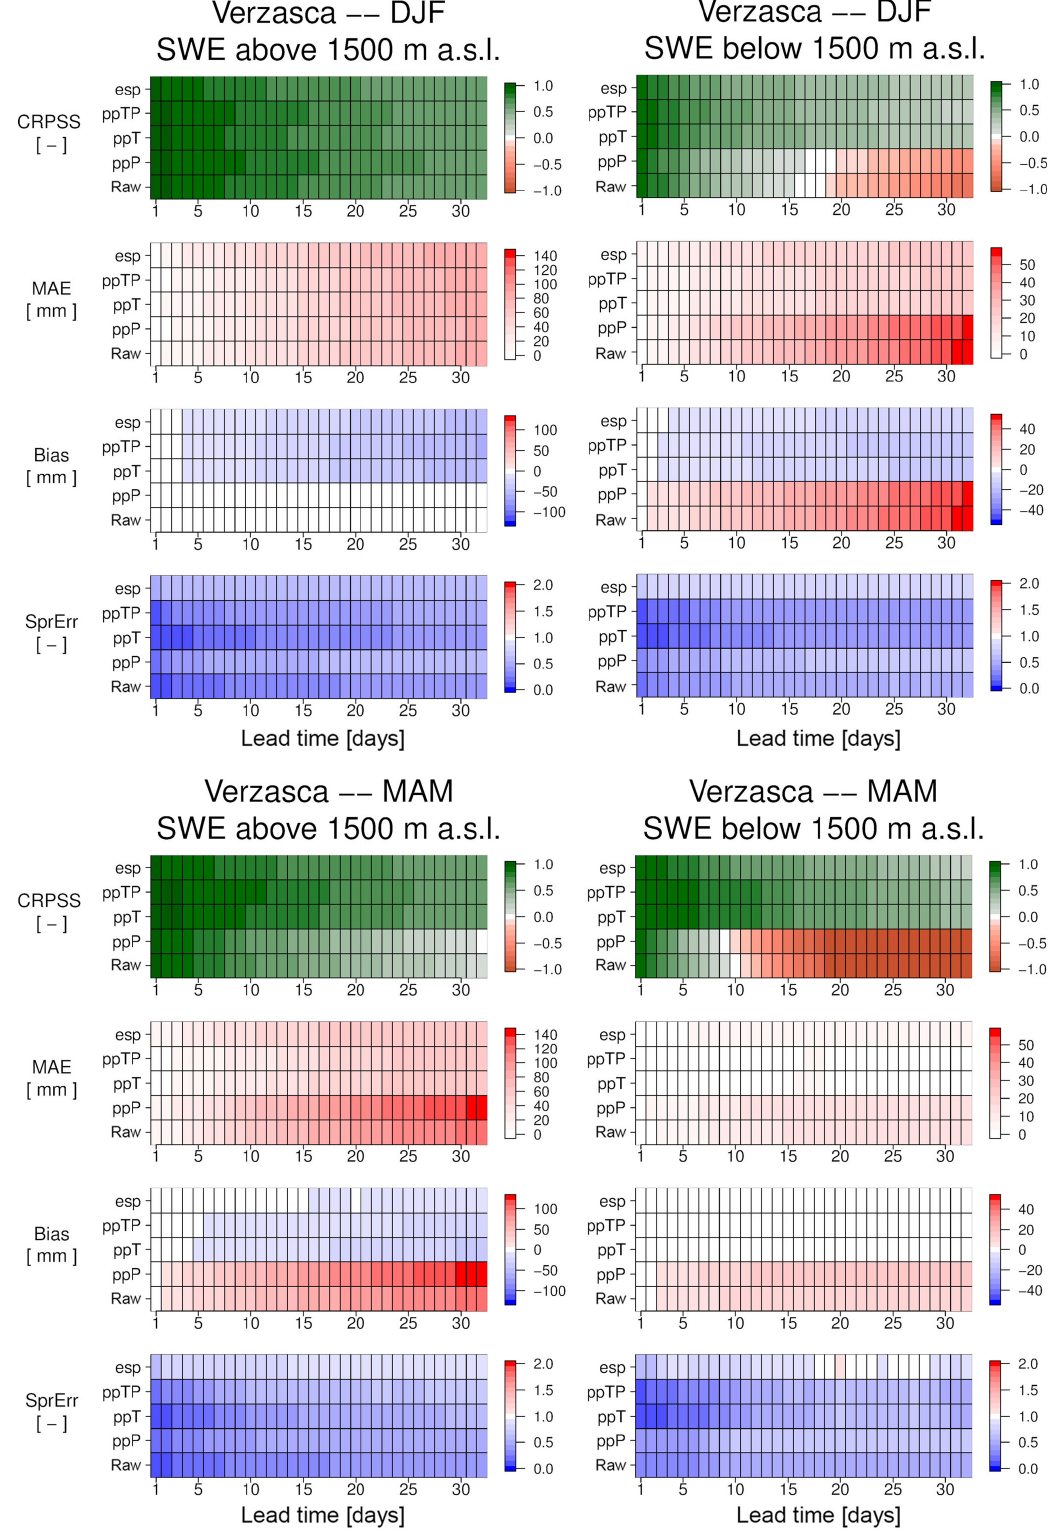
Figure 8. Same as in Fig. 5 but for SWE in DJF and MAM in the Verzasca catchment.